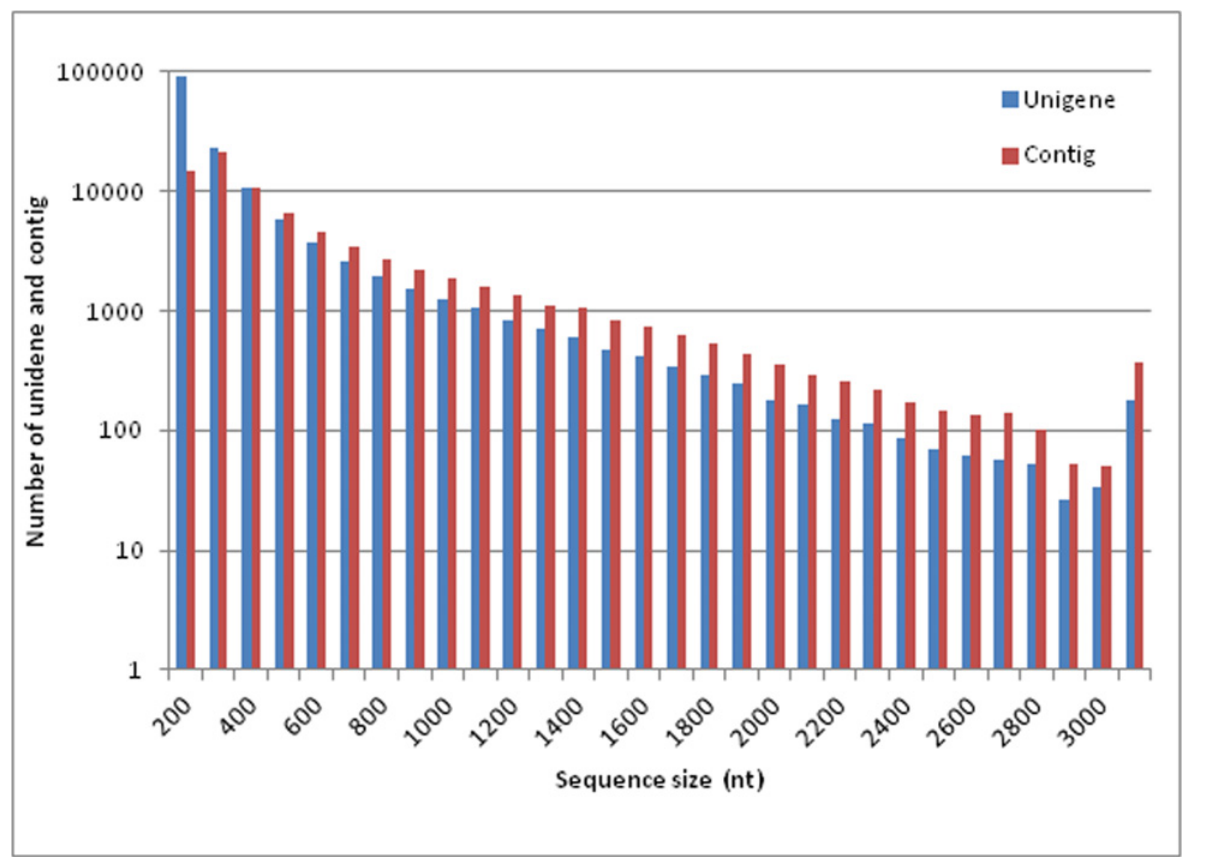
Fig 2. Size distributions of the contigs and unigenes in the American ginseng seed transcriptome.